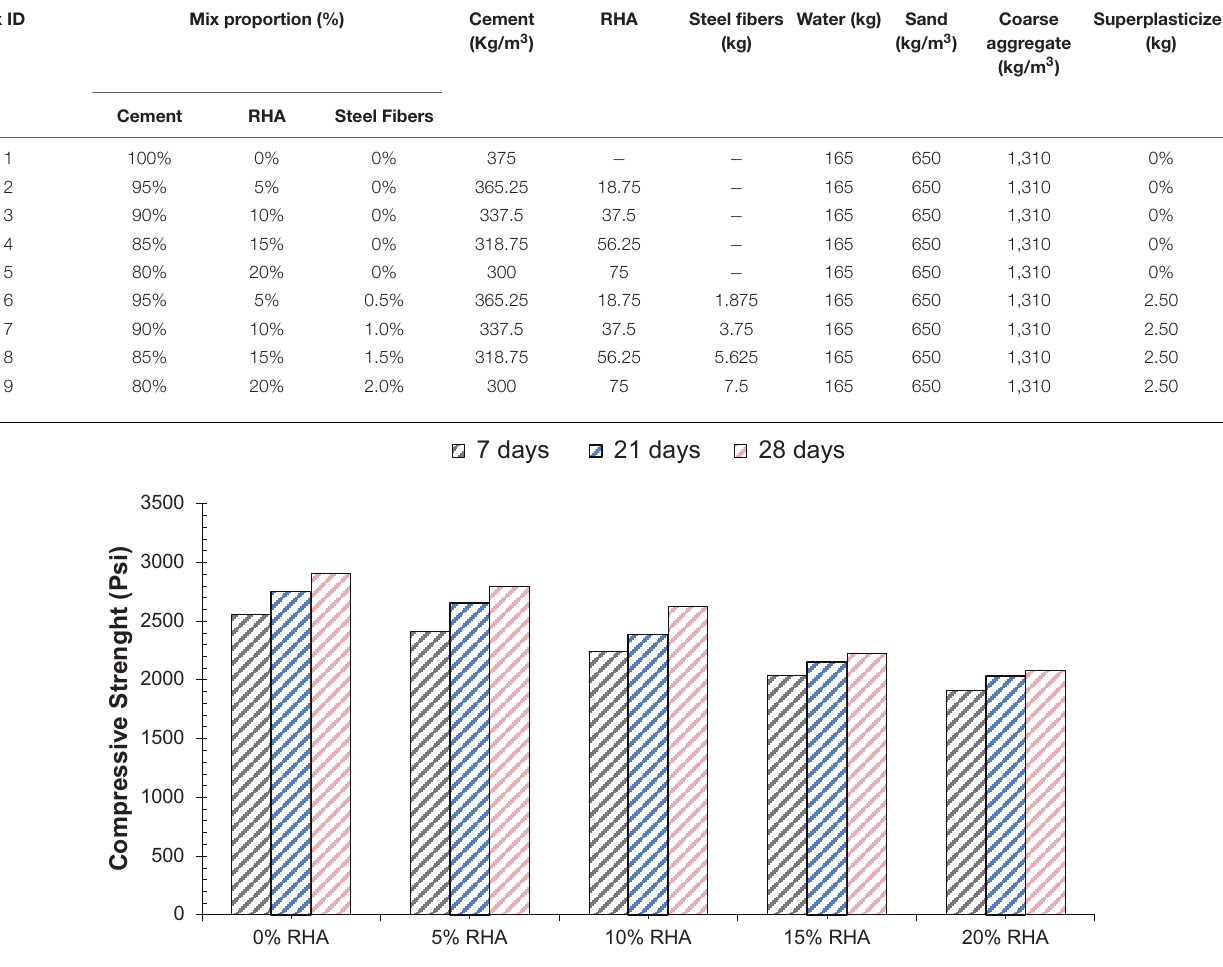
TABLE 6 | Quantification of materials.